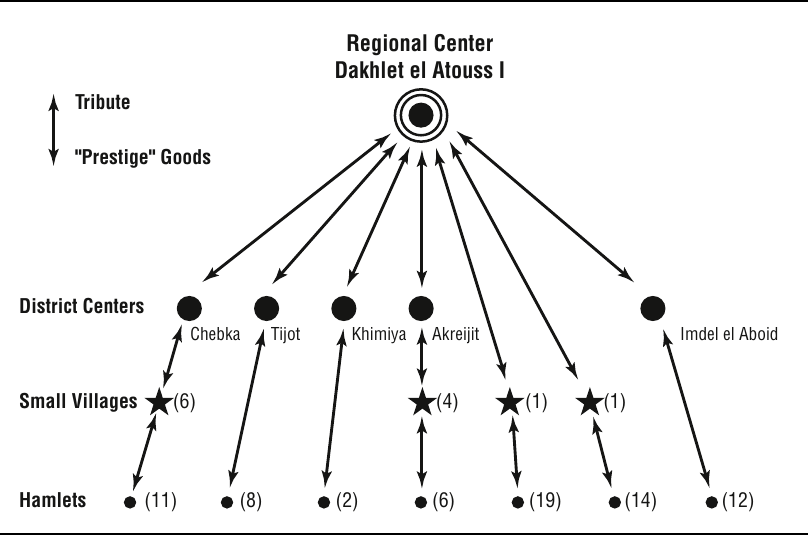
Figure 4 – Distribution of Tichitt Tradition Sites–Early 1st Millennium B.C. Figure 5 – Four-tier settlement hierarchy (Tichitt Tradition) with the directions for the flows of tribute and prestige